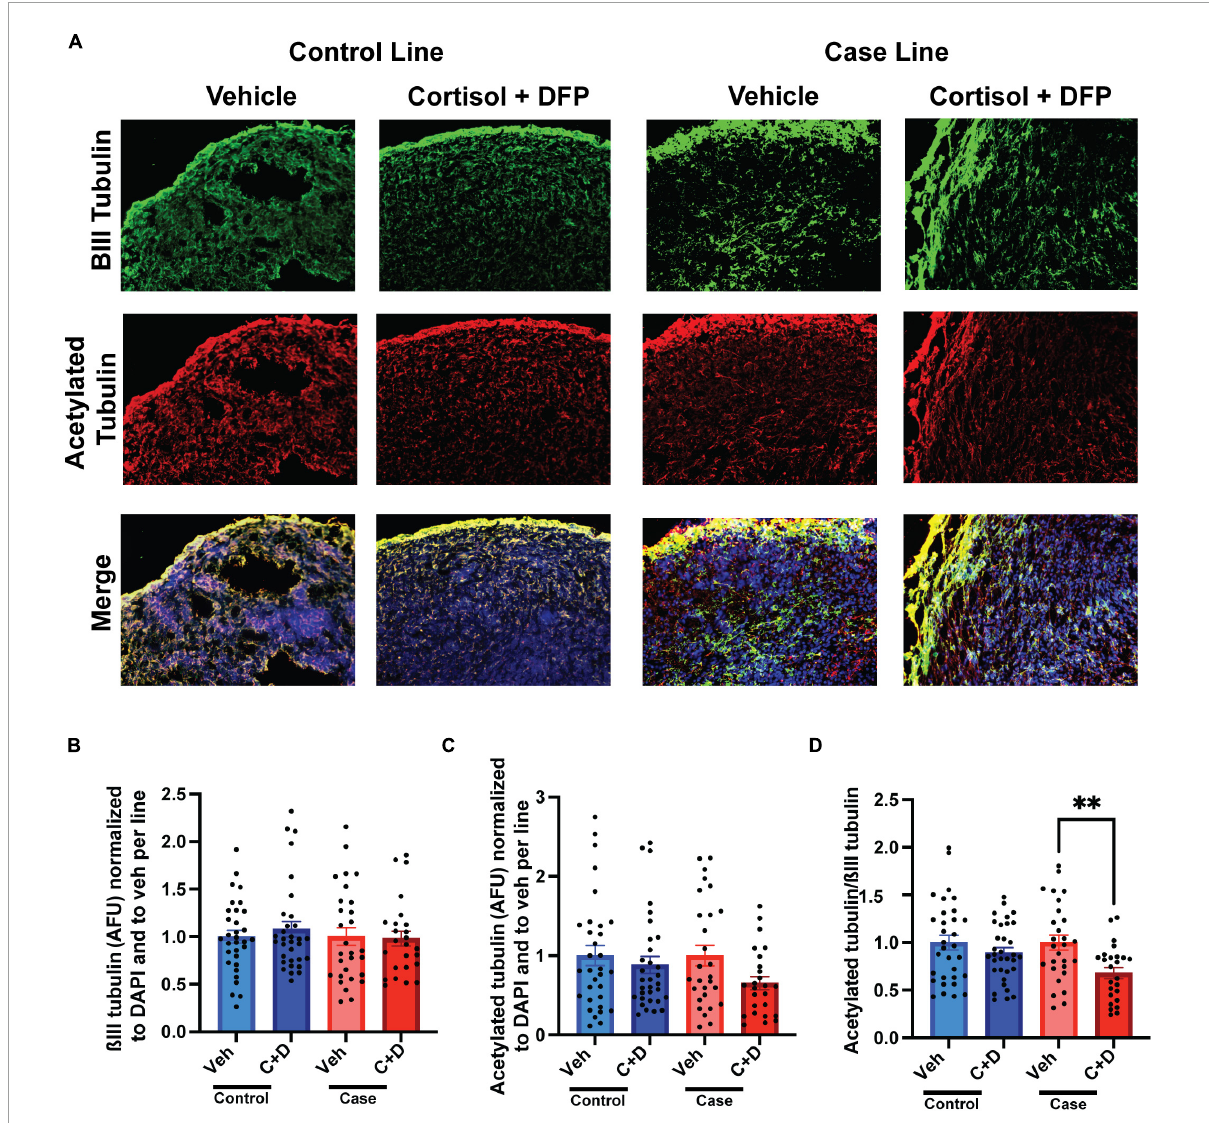
FIGURE3 Reduced microtubule acetylation in forebrain cerebral organoids exposed to Gulf War (GW) toxicants. (A) Representative immunofluorescence images from one control line and one case line exposed to 2 µ M cortisol plus 200 nM diisopropyl fluorophosphate (DFP) show staining for ßIII-tubulin (green) acetylated tubulin (red), and 4, 6-diamino-2-phenylindole (DAPI) (blue). (B) The graph shows mean arbitrary fluorescence units (AFU) ± SEM of ßIII tubulin normalized to DAPI per line and to vehicle per line. (C) The graph shows mean AFU ± SEM of acetylated tubulin normalized to DAPI per line and to vehicle per line. (D) The graph shows the ratio of acetylated tubulin ßIII normalized to DAPI per line and to vehicle per line. The acetylated tubulin/ßIII tubulin ratio decreased in the case line by 31.95% (0.3195 ± 0.0582). ∗∗ p <